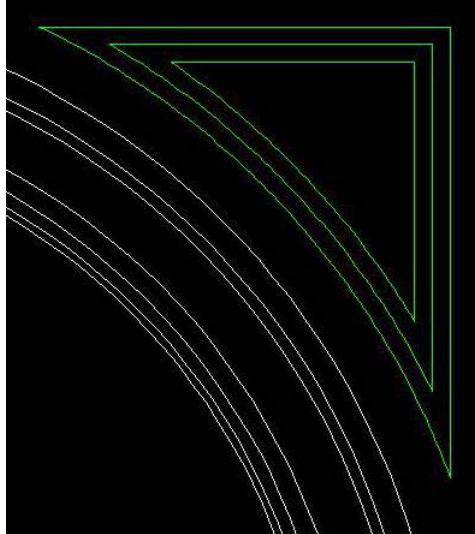
Picture 17: Idealised elements (green)